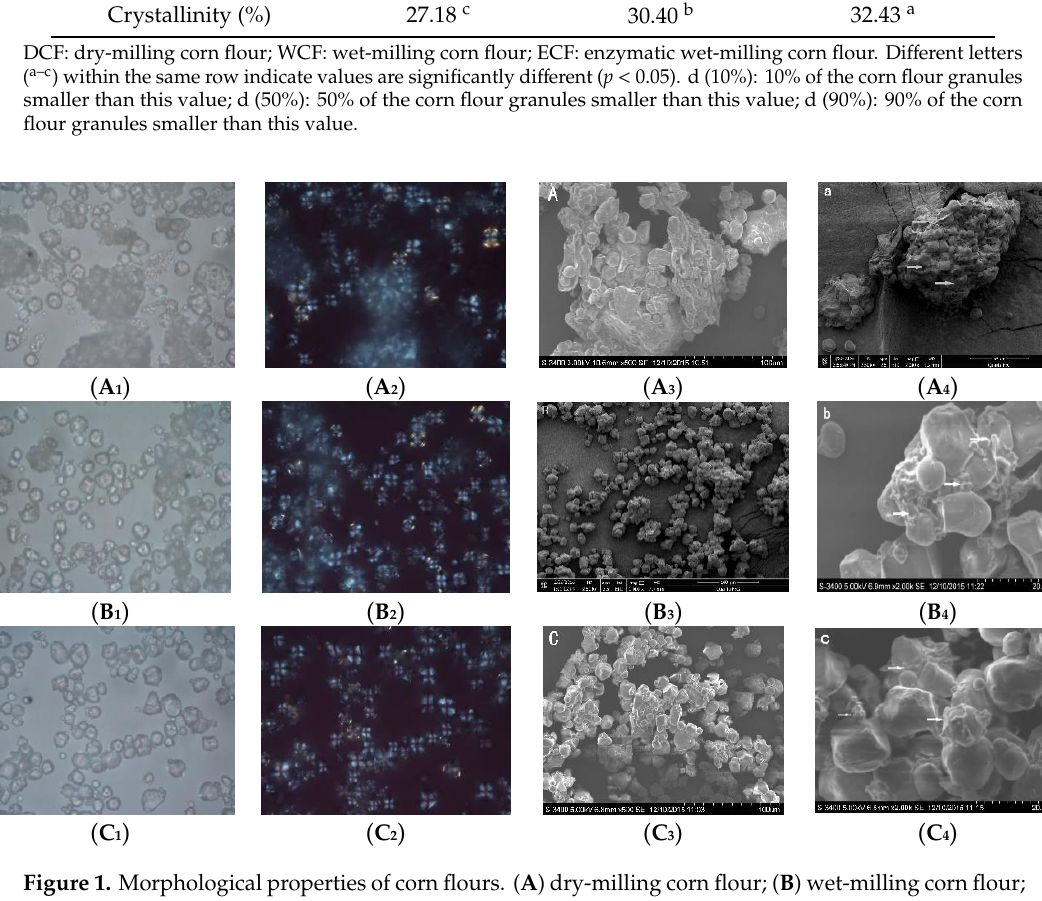
Table 1. The chemical composition analysis, size distribution and crystallinity of corn flours.